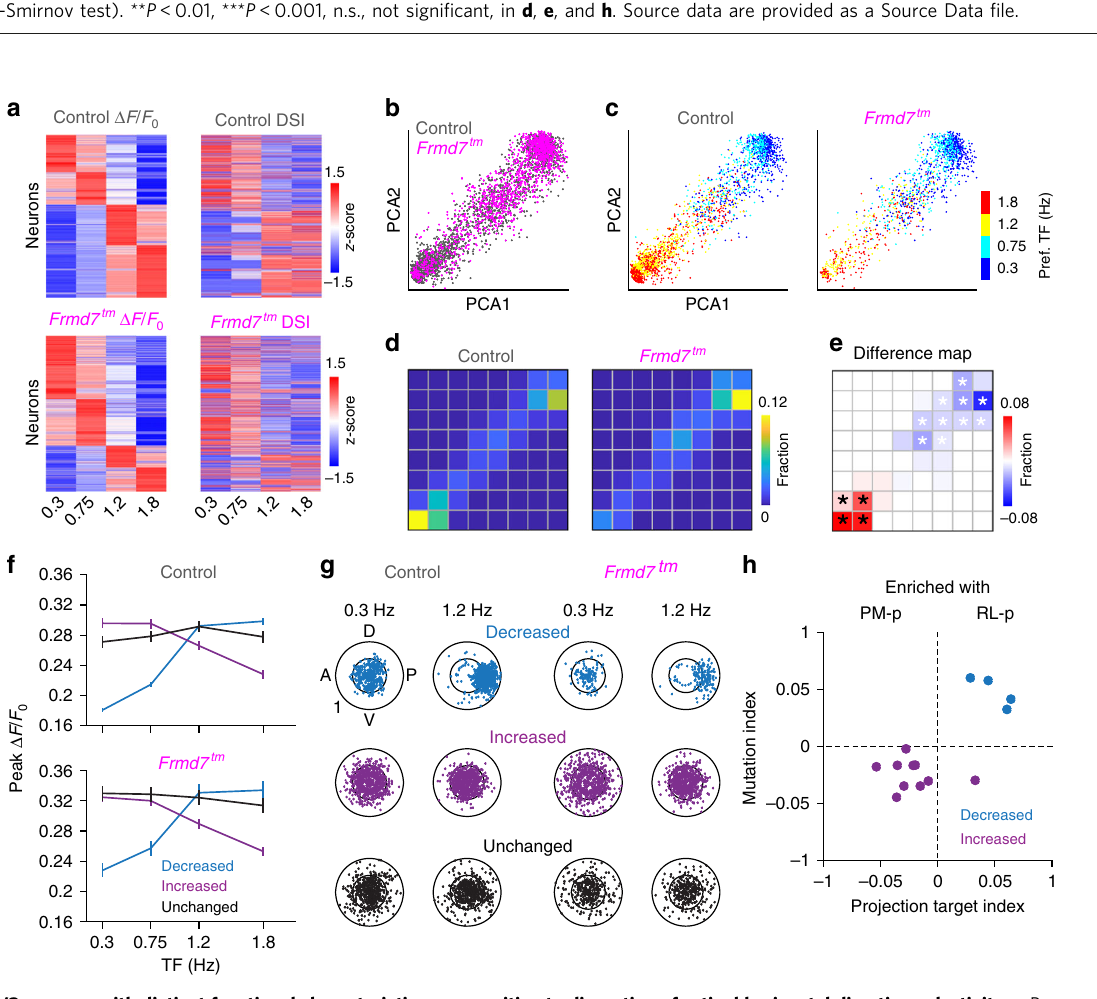
Fig. 3 V1 DS cells projecting to area RL or PM respond differently to disruption of retinal direction selectivity. a Target-unspeci fi c V1 neurons were labeled by injecting AAV2/1-GCaMP6f into the V1. PM- (PM-p) and RL-projecting (RL-p) V1 neurons were labeled by injecting rAAV2-retro-GCaMP6m into PM and RL, respectively. b Two-photon calcium imaging from L2/3 in V1 of control (1087 target-unspeci fi c, 109 PM-p, and 513 RL-p DS cells; 5 mice per group) and Frmd7 tm mice (954 target-unspeci fi c, 93 PM-p, and 235 RL-p DS cells; fi ve mice per group). Left: example PM- and RL-projecting neurons expressing GCaMP6m (scale bar, 10 µ m). Right: trial-averaged fl uorescence ( Δ F / F 0 ) time courses for the same neurons. Shading: SEM. c Tuning curves for neurons shown in b . Error bars: SEM. Solid line: Gaussian fi t. d Fraction of DS cells in target-unspeci fi c, PM-p, and RL-p V1 neuronal populations (two-sided χ 2 test with Yates correction). e Preferred TF for target-unspeci fi c (two-sided Mann – Whitney U -test), PM-p (two-sided Mann – Whitney U- test), and RL-p (two-sided Mann – Whitney U -test) V1 DS cells. Triangles: Medians. f Response amplitude as a function of motion direction and TF for target-unspeci fi c, PM-p, and RL-p V1 DS cells. White asterisks: signi fi cantly decreased in Frmd7 tm mice, two-sided Mann – Whitney U -test. g Fractional distributions of preferred motion directions for target-unspeci fi c, PM-p, and RL-p V1 DS cells at 0.3 and 1.2 Hz. The fractions are normalized to the largest fraction across genetic groups. h Distributions of preferred motion directions at 0.3 and 1.2 Hz for target-unspeci fi c, PM-p, and RL-p V1 DS cells (two-sided